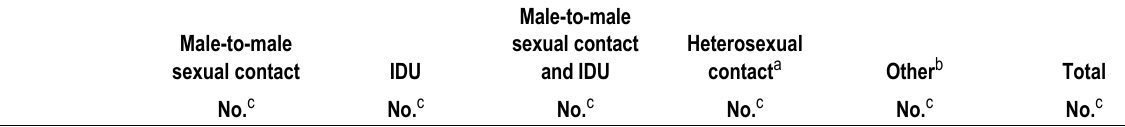
Table 5a. Diagnoses of HIV infection, by transmission category, race/ethnicity, and selected characteristics, 2015—United States